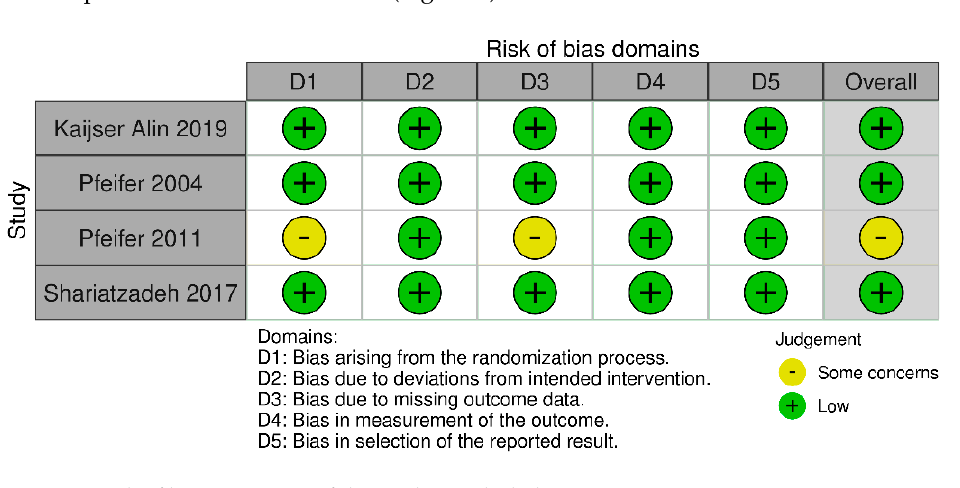
Table 1. Participants demographics, outcomes assessed, intervention characteristics, and results of included studies.